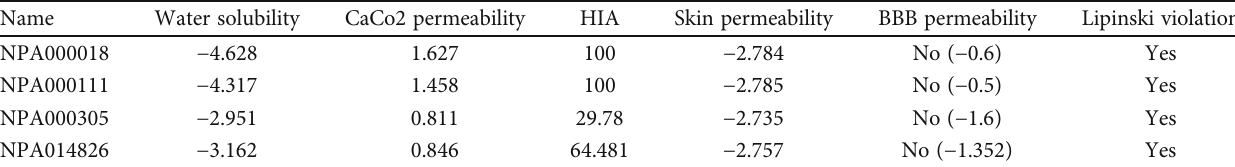
Table 2: ADME property analysis of the shortlisted compounds.